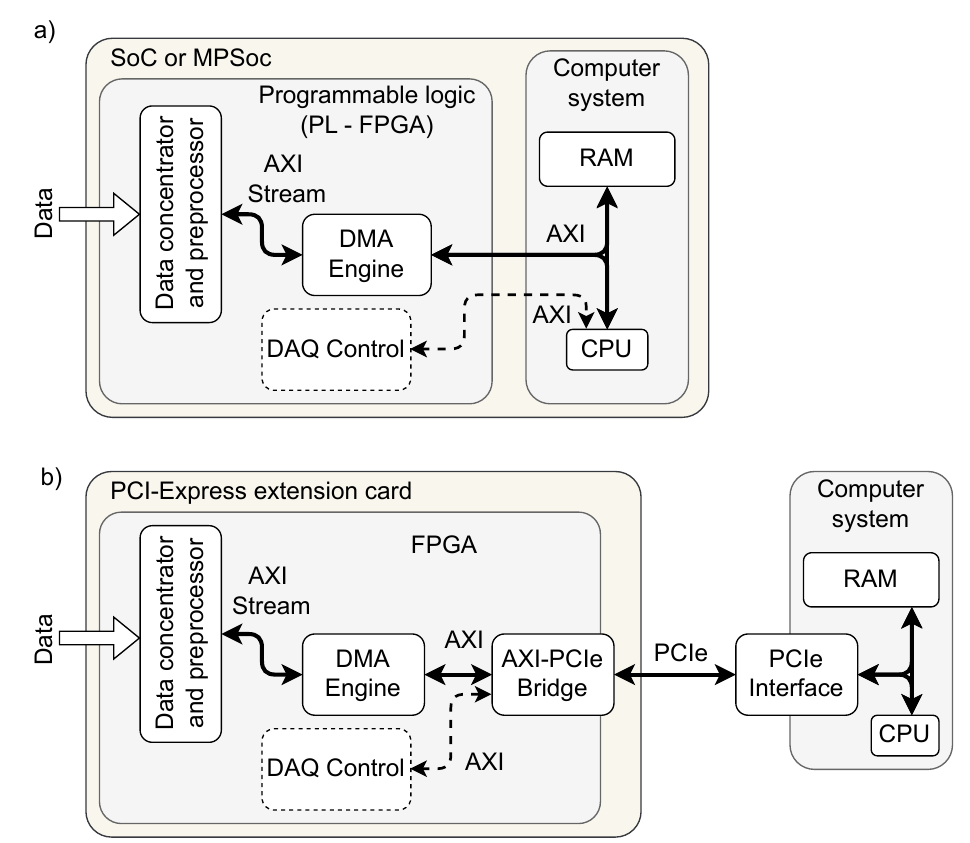
Figure 1. Two typical hardware architectures using the DMA engine implemented in FPGA; ( a ) based on MPSoC with FPGA and processing system connected directly via AXI interface, ( b ) based on a FPGA-equipped PCIe extension card. The AXI-PCIe bridge enables using the same DMA engine as in case ( a ). The “DAQ Control” block represents other user-defined logic in FPGA used to control the DAQ system. It is connected to a separate AXI bus and accessible as another character device in Linux (see Section